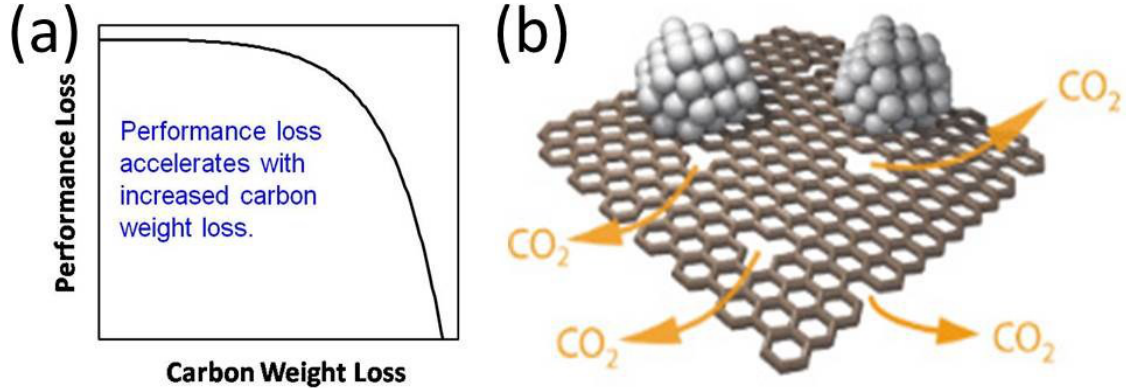
Figure 1. Relationship of carbon corrosion and activity loss in fuel cells ( a ) and illustration of catalyst detachment from corroded carbon ( b )